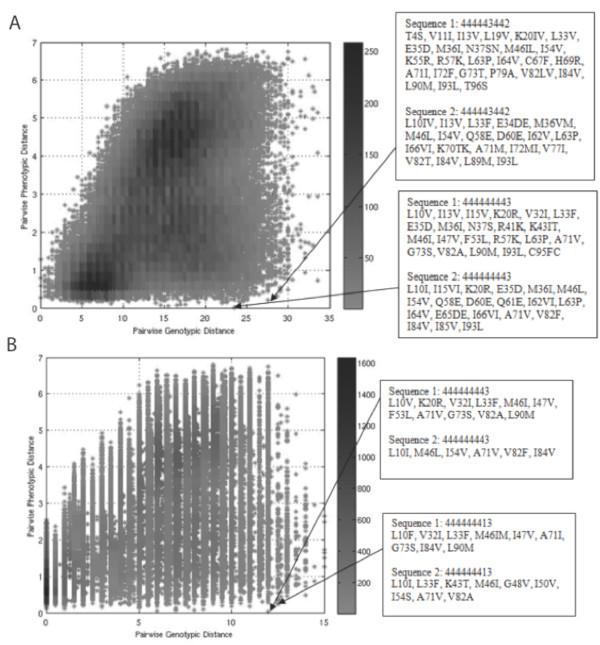
Pairwise phenotypic distance vs. pairwise genotypic distance for all pairs of sequences. (a) Scaled phenotypic distance vs. genotypic distance with all positions considered in calculating genotypic distance and (b) with only resistance-associated positions used in calculating genotypic distance. The density of points is colored according to the scale at right. The sequence pairs corresponding to two points are indicated. The 9-digit shorthand used to describe the two pairs of sequences indicates the resistance score (Table 2) to the PIs in the order used in Fig. 1: RTV, NFV, ATV, APV, IDV, LPV, SQV, TPV, DRV.